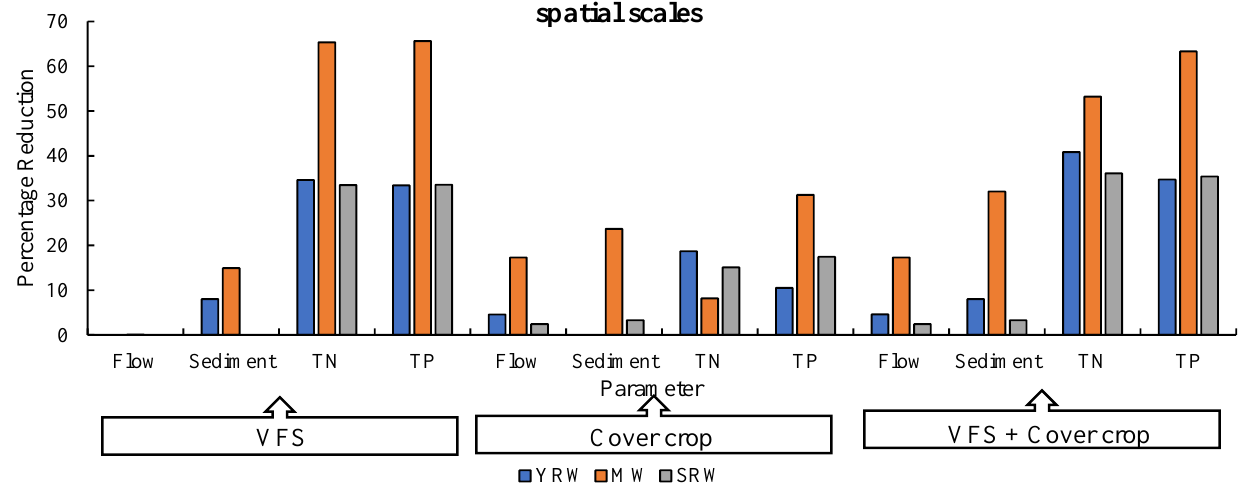
Figure 4. Comparative analysis of percentage reductions in streamflow, sediment, TN, and TP loads between field- and watershed-scale models when BMPs were implemented.